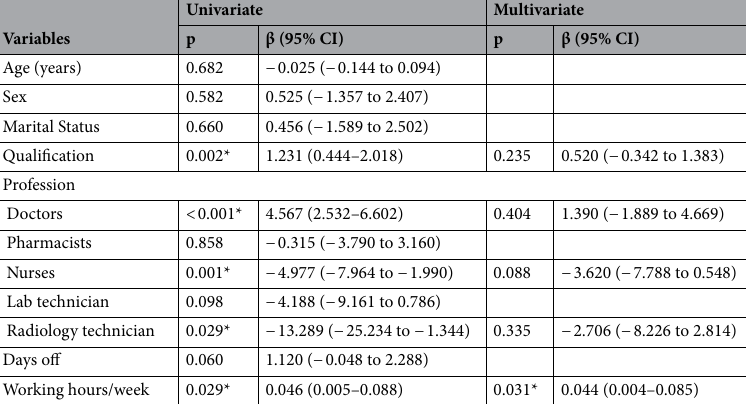
Table 3. Regression analysis for the parameters affecting burnout syndrome among frontline healthcare professionals in Egypt. R 2 = 0.147, F = 5.007*, p < 0.001* β: Unstandardized Coefficients C.I: Confidence interval *: significant at p ≤